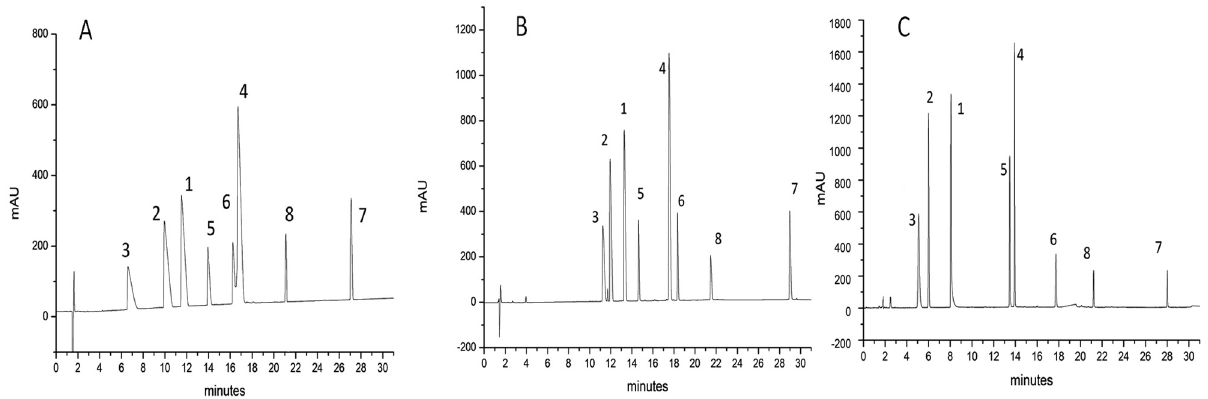
Figure 2. Chromatograms refer to the separation of eight peptides (see Table 1). Column used: ACQUITY UPLC ® BEH C4 (150 × 2.1 mm L × I.D.) 1.7 µ m 300 Å FPP and BEH particle. ( A ) MP with 0.1% v/v FA; ( B ) MP with 0.1% v/v TFA; ( C ) MP with 10 mM TBAHSO 4 .